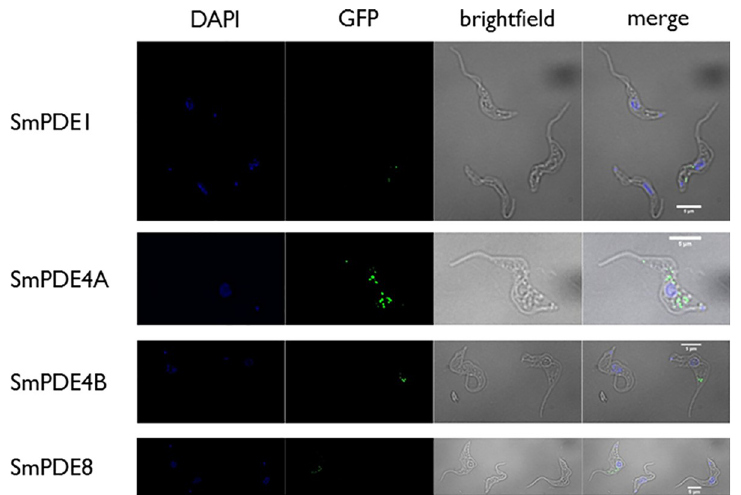
Fig 4. Immuno-localization of SmPDEs after expression in T . brucei . T . brucei 2T1 cells from which a single TbrPDEB1/B2 was deleted, and expressing either SmPDE1, SmPDE4A, SmPDE4B or SmPDE8, C-terminally fused to GFP and N-terminally tagged with the first 70 aa of TbrPDEB1, were fixed, and stained with DAPI (blue fluorescence) to reveal the nucleus and kinetoplast. The location of the GFP tag, and thus the position of the SmPDE was revealed using antibodies against GFP (green